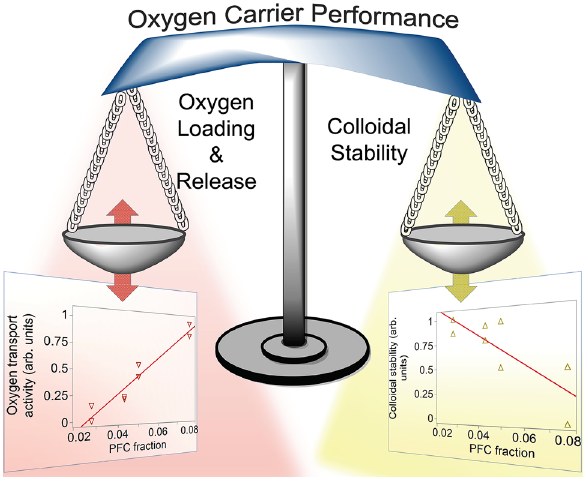
Figure 2. Balancing of opposing key attributes of PFC-NE O 2 carriers. Highly concentrated PFC-NEs are sought for their high capacity for oxygen loading. However, biphasic PFC-NEs can be poorly stable. A key objective is to find a balance between these opposing quality attributes. Conceptual scatterplots (formed using JMP Pro) were formed by normalizing CQAs C max and Thermal stability Δsize into a number ranging from 0 to 1 by dividing each by the maximum respective CQA measurement (Balance graphic drawn in ChemDraw).